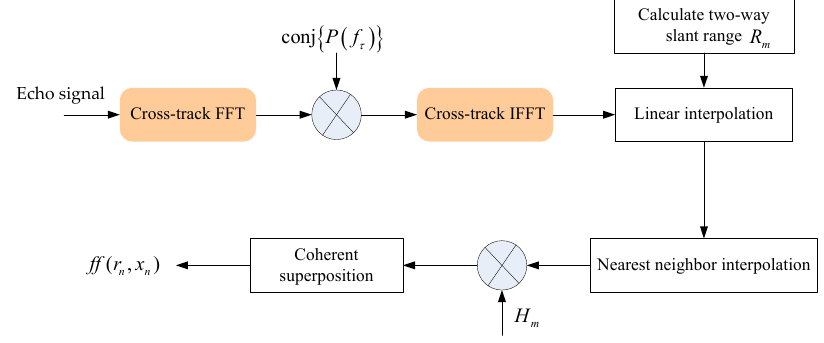
Figure 5. Block diagram of presented method.